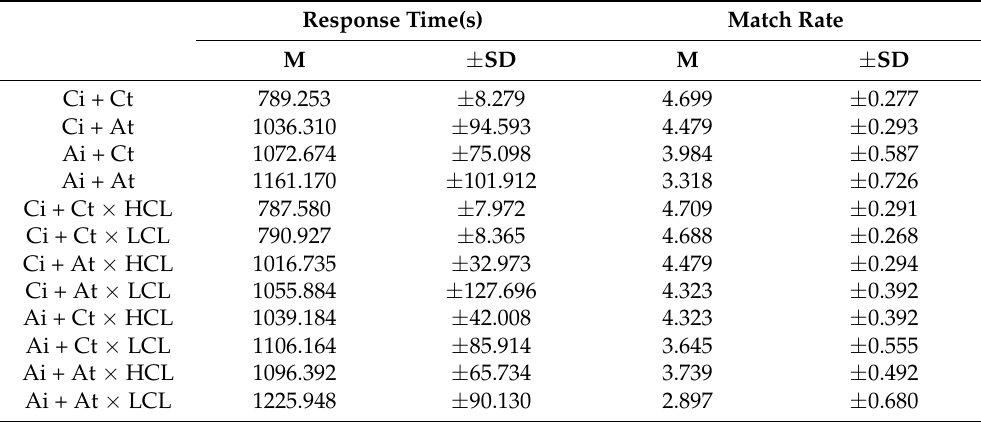
Table 3. Mean (standard deviation) of response time and match rate for different combinations of design type icons and construal